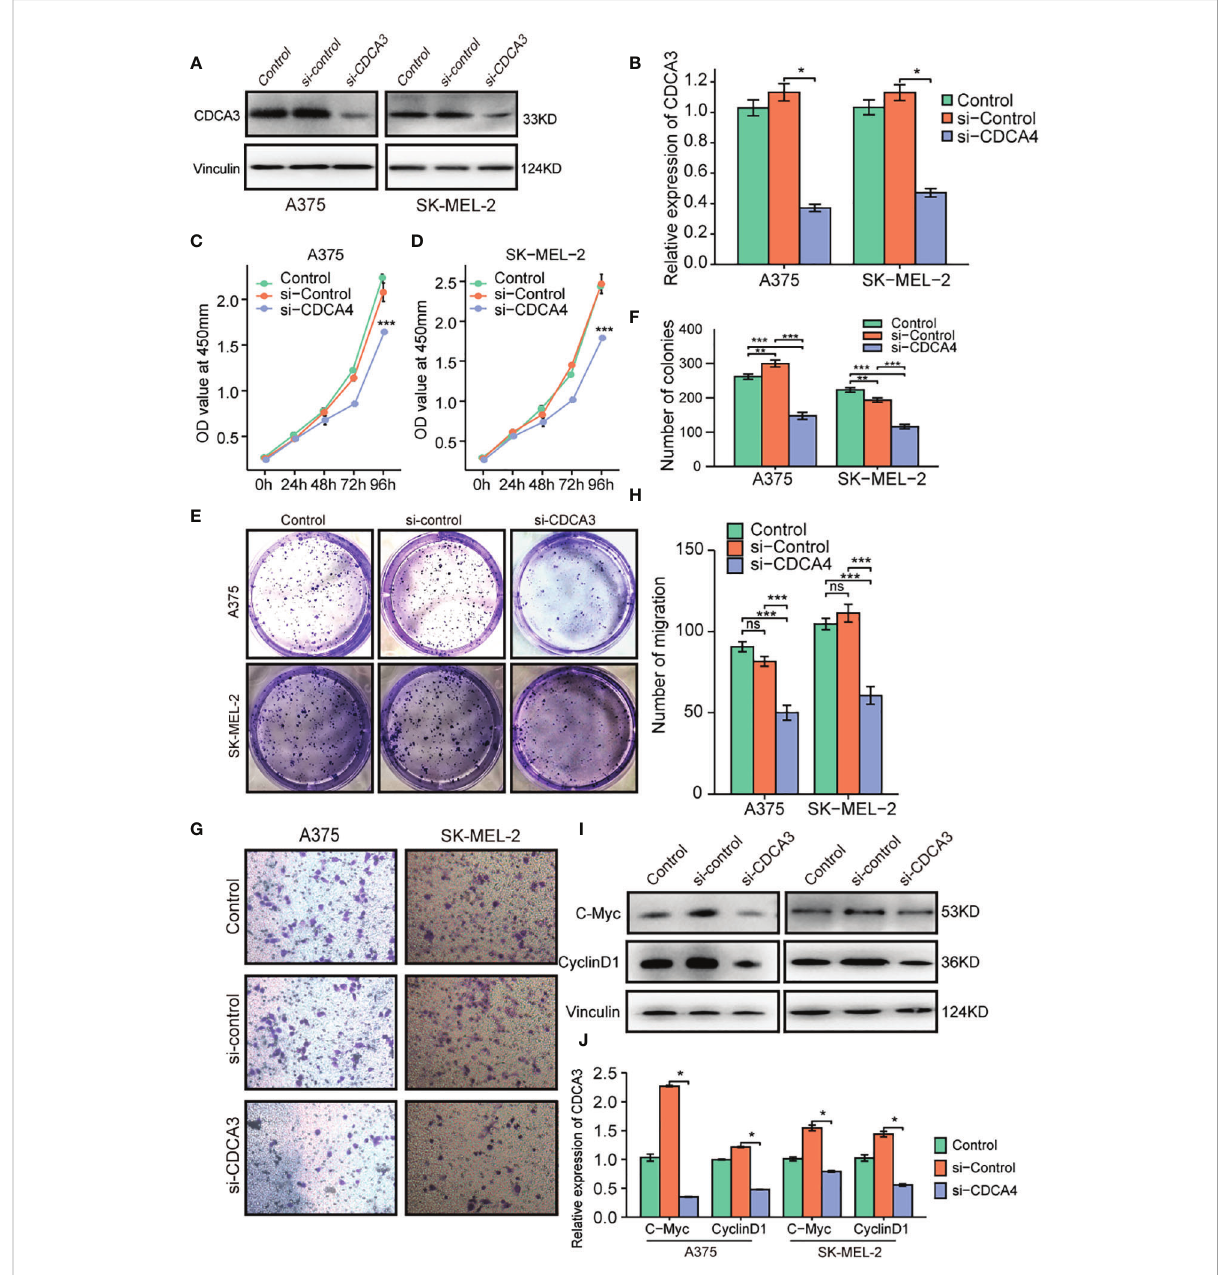
FIGURE 9 Decreased CDCA3 expression inhibits the proliferation and migration of cutaneous melanoma cells in vitro . (A) The si-CDCA3 transfection ef fi ciency in A375 and SK-MEL-2 cell lines was explored via western blotting. (B) Representative statistical analysis of CDCA3 expression in the control, si-control, and si-CDCA3 groups. (C, D) CCK-8 assays were applied to detect the effect of CDCA3 knockdown on the proliferation of A375 and SK-MEL-2 cell lines. (E) Images of colony formation assay results after CDCA3 knockdown in the A375 and SK-MEL-2 cell lines. (F) Representative statistical analysis of the colony formation assay results, including the control, si-control, and si-CDCA3 groups. (G) Images of the transwell assay results after CDCA3 knockdown in the A375 and SK-MEL-2 cell lines. (H) Representative statistical analysis of the transwell assay results. (I) The expression of C-Myc and CyclinD1 was explored by western blotting. (J) Representative statistical analysis of C-Myc and CyclinD1 expression in the control, si-control, and si-CDCA3 groups. *p < 0.05; **p < 0.01; ***p < 0.001; NS, no signi fi